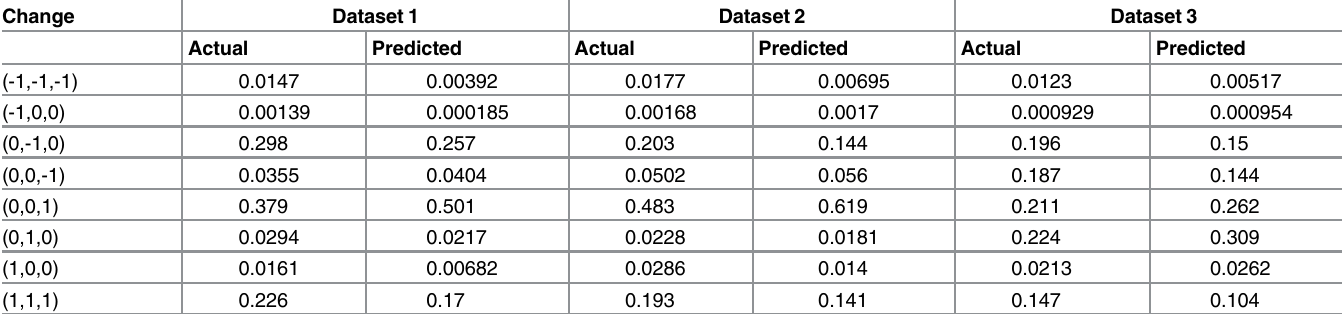
Table 1. Actual and predicted parameters for the ploidy-based